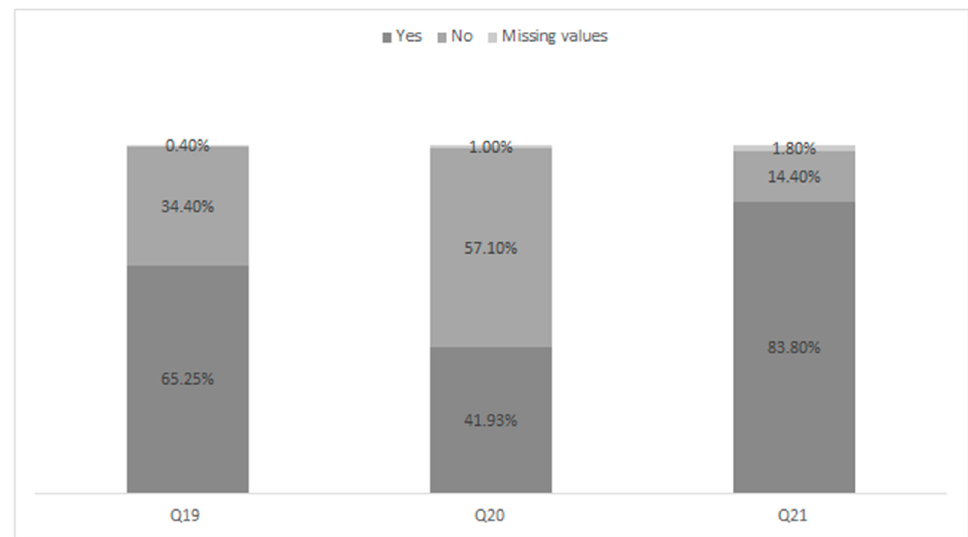
Figure 1. Clinical management for orthotics, instrumental therapies and neuro/tendons glides techniques. Tabled as percentage of respondent ( n = 508). Q: question. Q19: Orthotic; Q20: Instrumental Therapies; Q21: Neurodynamic/tendons glides techniques.